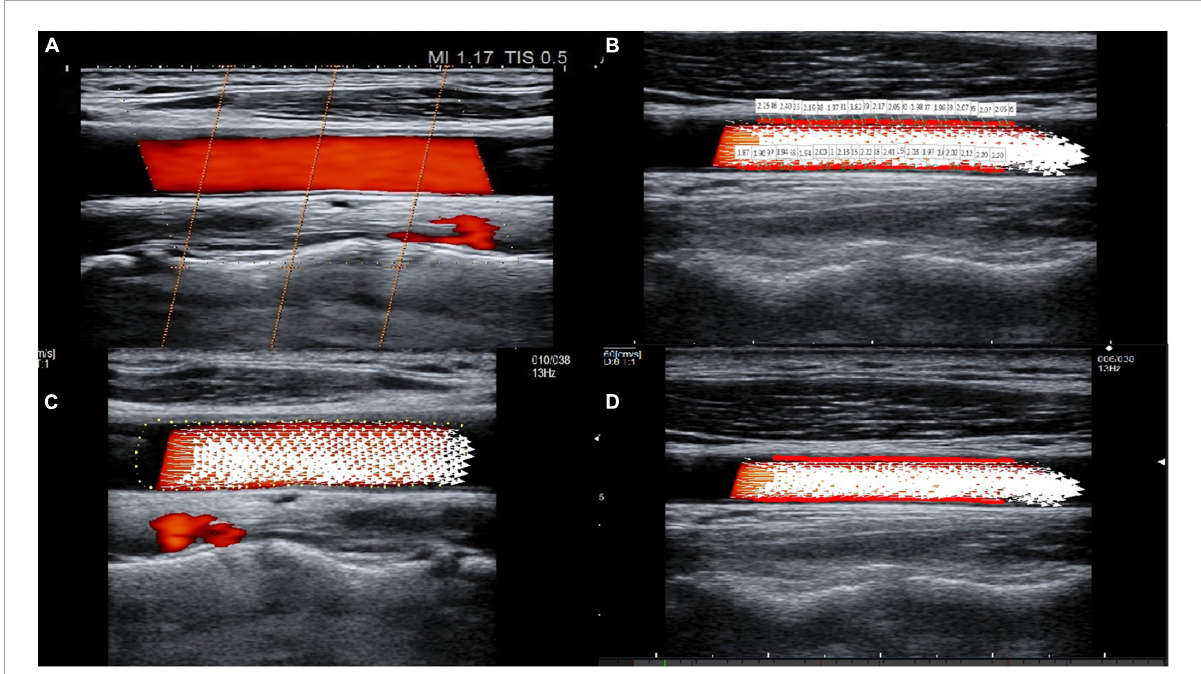
FIGURE1 The visualization of common carotid artery blood flow and the quantitative calculation of WSS. (A) Three sound beams intersecting with the color Doppler appear when the VFM button is activated. Cross-beam vascular VFM creates a starting point to replace the vessel wall, and it obtains blood flow velocity information perpendicular to the direction of the color Doppler. (B) Tracing of the intima of the anterior and posterior walls of the common carotid artery and visualization of the WSS at each point of the anterior and posterior walls of the carotid artery. (C) The white arrow represents the blood flow velocity vector of the carotid artery. (D) The red line(s) on the vessel wall indicates that the WSS is